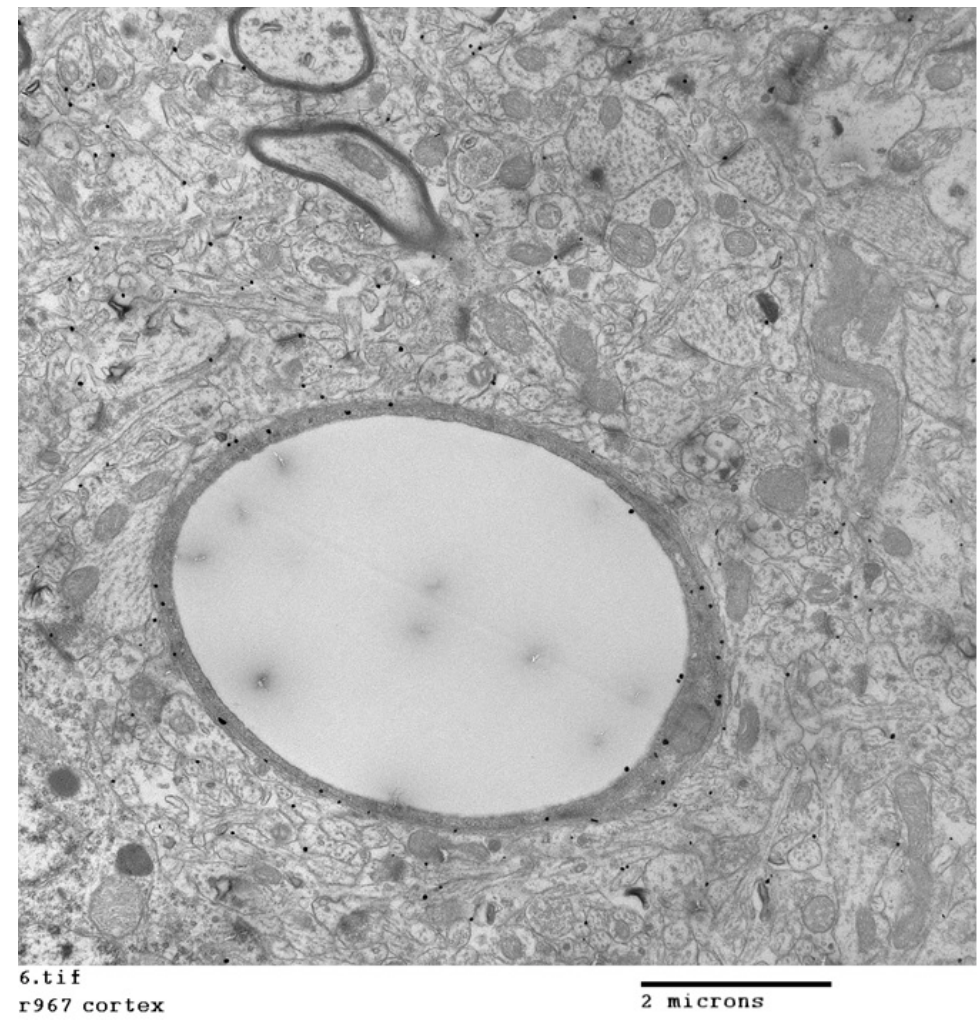
Figure 1. Transfer of 5-nm pegamine-coated gold nanoparticles across the rat brain endothelium. A silver-enhanced TEM image of cortex 10 min after intra-carotid infusion shows nanoparticles (black electron-dense dots) located in the endothelium of a capillary, in astrocyte foot processes adjoining the vessel and in neurons up to 4 µm from the vessel. Image is courtesy of Dr. Radka Gromnicova.